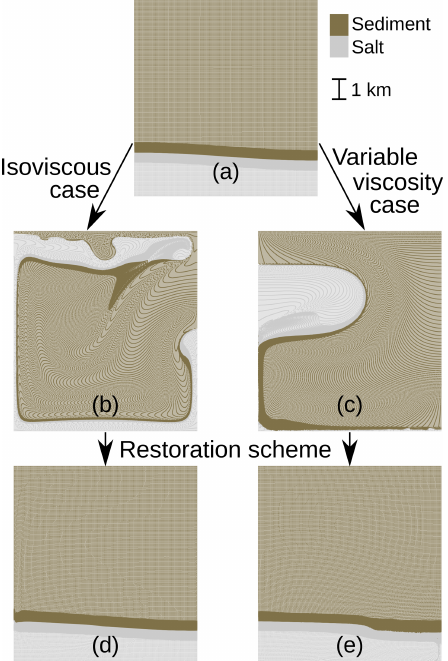
Figure 5. Particle swarms for the two synthetic diapiric growth ex- periments. The darker grey and brown parts on the swarms are due to the higher density of particles around the interfaces. The parti- cles have the same initial position (a) in the two experiments, with different material properties. The result of the forward simulation after 6 × 10 6 years for the first experiment is shown in panel (b) . Panel (c) shows the result of the forward simulation for the sec- ond experiment after 1 . 5 × 10 6 years. The results for the restoration simulations are shown in panels (d) and (e) for the first and second experiments, respectively.